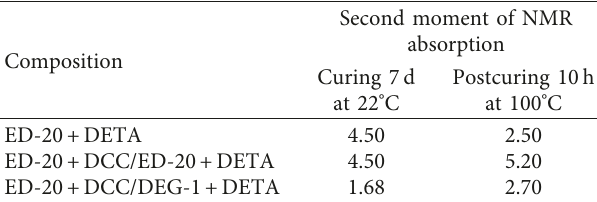
Figure 1: Changes in the content of epoxide (a) and cyclocarbonate groups (b) during the curing of ED-20 +DCC/DEG-1+DETA compositions as a function of the DCC/DEG-1 content with 0% (1), 20% (2), 40% (3), 50% (4), and 60% (5). Table 4: Influence of modifiers (20% OECC) and ED-20 +DETA composition curing at the second moment of NMR absorption.